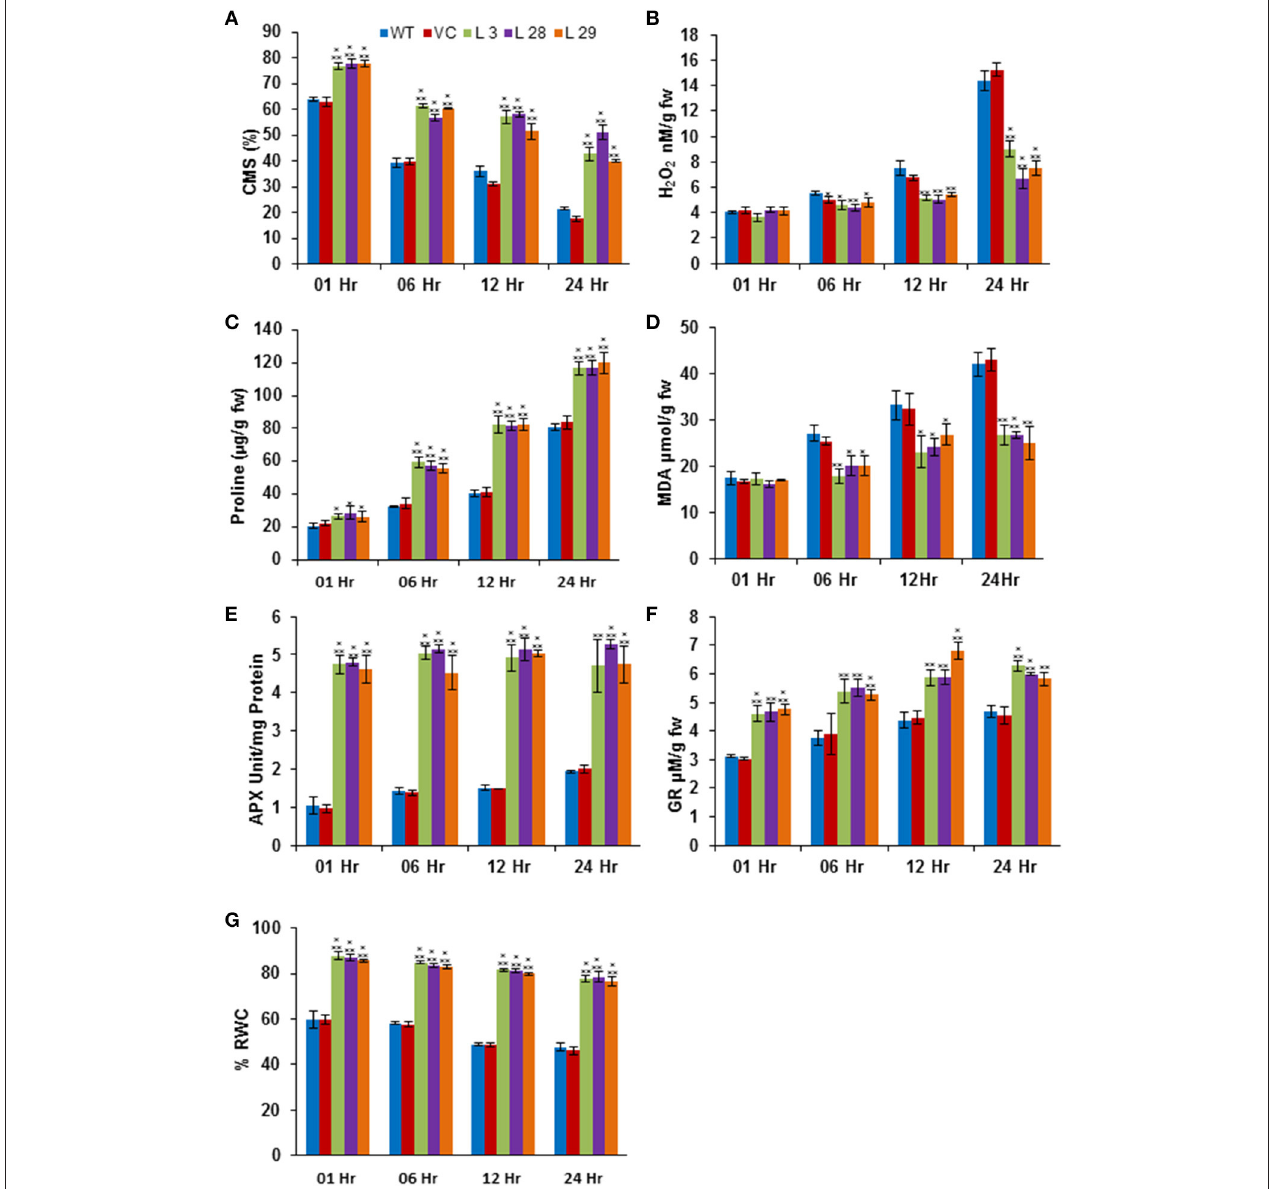
FIGURE 5 | Biochemical and physiological responses of SbSLSP transgenic plants, and VC and WT under salinity stress (250mM NaCl). (A) Percentage of cell membrane stability. (B) Changes in hydrogen peroxide content. (C) Changes in the level of proline accumulation. (D) Levels of lipid peroxidation expressed in terms of MDA content. (E) Changes in ascorbate peroxidase enzyme activity. (F) Changes in glutathione reductase enzyme activity. (G) Percentage of relative water content. One-way analysis of variance (ANOVA) was used to test the significance between the mean values of control and transgenic plants, and comparison among mean values was performed using ezANOVA (http://www.cabiatl.com/mricro/ezanova/). The difference between control and transgenic lines were statistically significant at * P < 0.05, ** P < 0.01 and *** P <